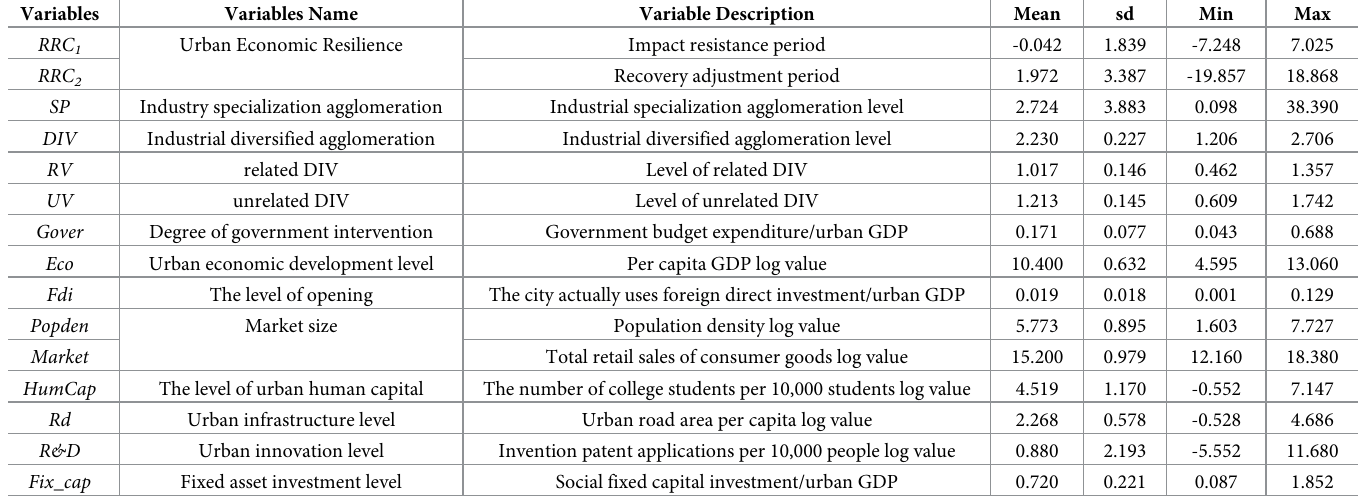
Table 1. Descriptive statistics of related